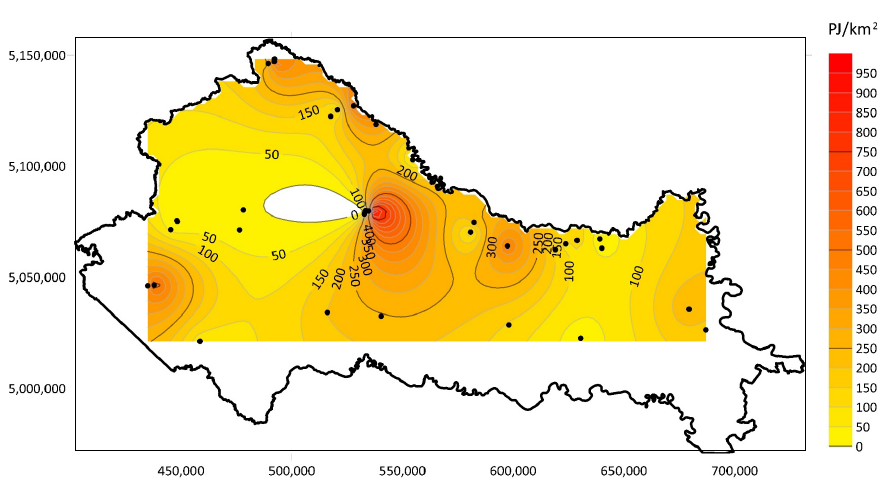
Figure 18. Mean heat-in-place areal distribution—pre-rift phase.